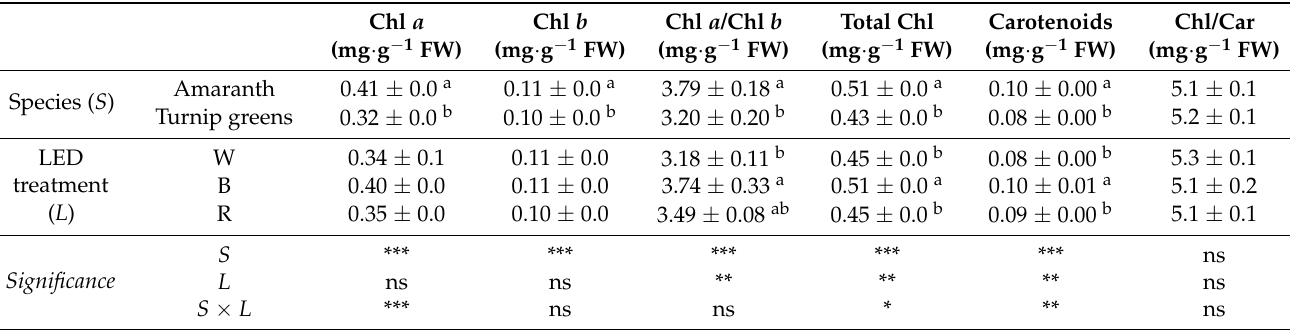
Values (mean ± se ) within each column, followed by the same letter, do not significantly differ at p ≤ 0.05 according to Tukey’s test; ns = not significant; significant at p ≤ 0.05 (*), 0.01 (**), and 0.001 (***). Three biological replicates were used for the analysis ( n =